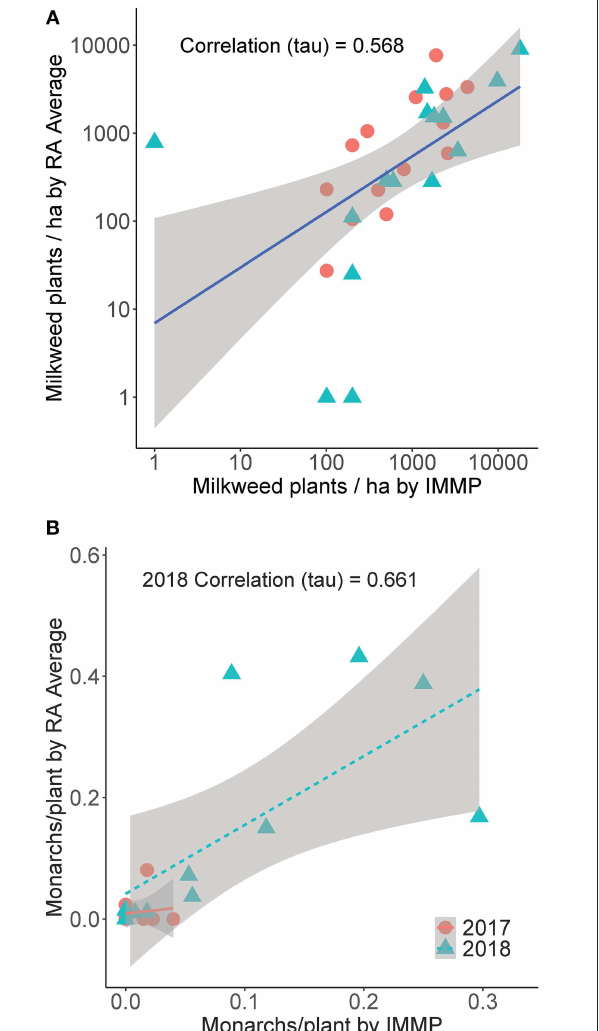
FIGURE 5 | (A) Comparison of milkweed density (milkweed plants/ha), log 10 transformed, for sites monitored in 2017 (circle) and 2018 (triangle), using the Integrated Monarch Monitoring Program (IMMP) and Roadside Habitat for Monarchs Rapid Assessment (RA) averaged for each site. 95% confidence interval indicated in gray. (B) Monarch eggs and larvae per milkweed plant searched (monarchs/plant), log 10 transformed, for sites monitored in 2017 (circle) and 2018 (triangle), for the same two methodologies. 95% confidence interval indicated in gray. The correlation between techniques for 2017 was